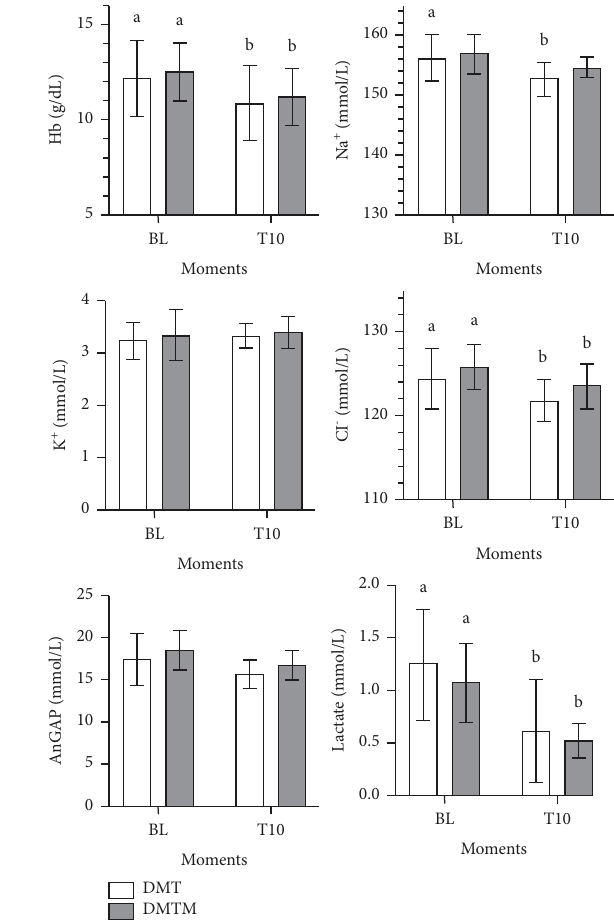
Figure 10: Values of arterial hemoglobin (Hb), arterial plasmatic sodium, potassium, and chloride (Na+, K +, Cl − , respectively), anion gap concentration (AnGAP), and arterial lactate plasma concentration (lactate) in 18 felines sedated with the association of dexmedetomidine (7.5ug/kg) and methadone (0.3mg/kg) (DMT, n � 9) or dexmedetomidine (5ug/kg), methadone (0.3mg/kg), and midazolam (0.3mg/kg) (DMTM, n � 9), both by the intramuscular route. Values are presented as mean ± standard deviation. a, b: diferent lowercase letters indicate a signifcant diference between moments within the same group according to the Tukey test ( p < 0 .